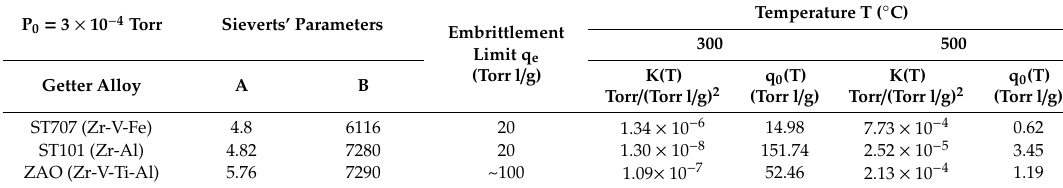
Table 1. Sieverts’ constants K(T) and surface equilibrium concentrations q 0 (T) at pressure P 0 and at temperatures of 300 and 500 °C, for some common getter alloys.